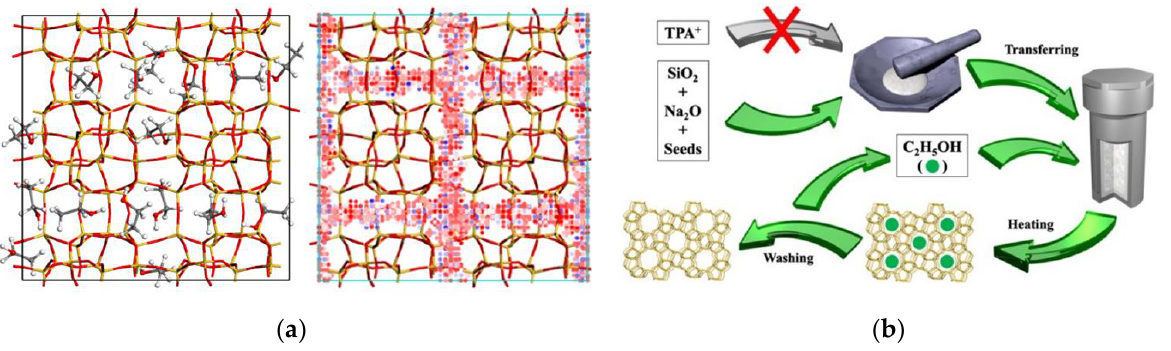
Figure 4. ( a ) The position of ethanol adsorbed in the micropore of silicalite-1 zeolite and the corresponding potential energy of isodensity surface; ( b ) schematic representation for synthesizing pure silica zeolites. Blue represents low potential energy. Reprinted with permission from ref. [113]. Copyright 2019, Wiley.